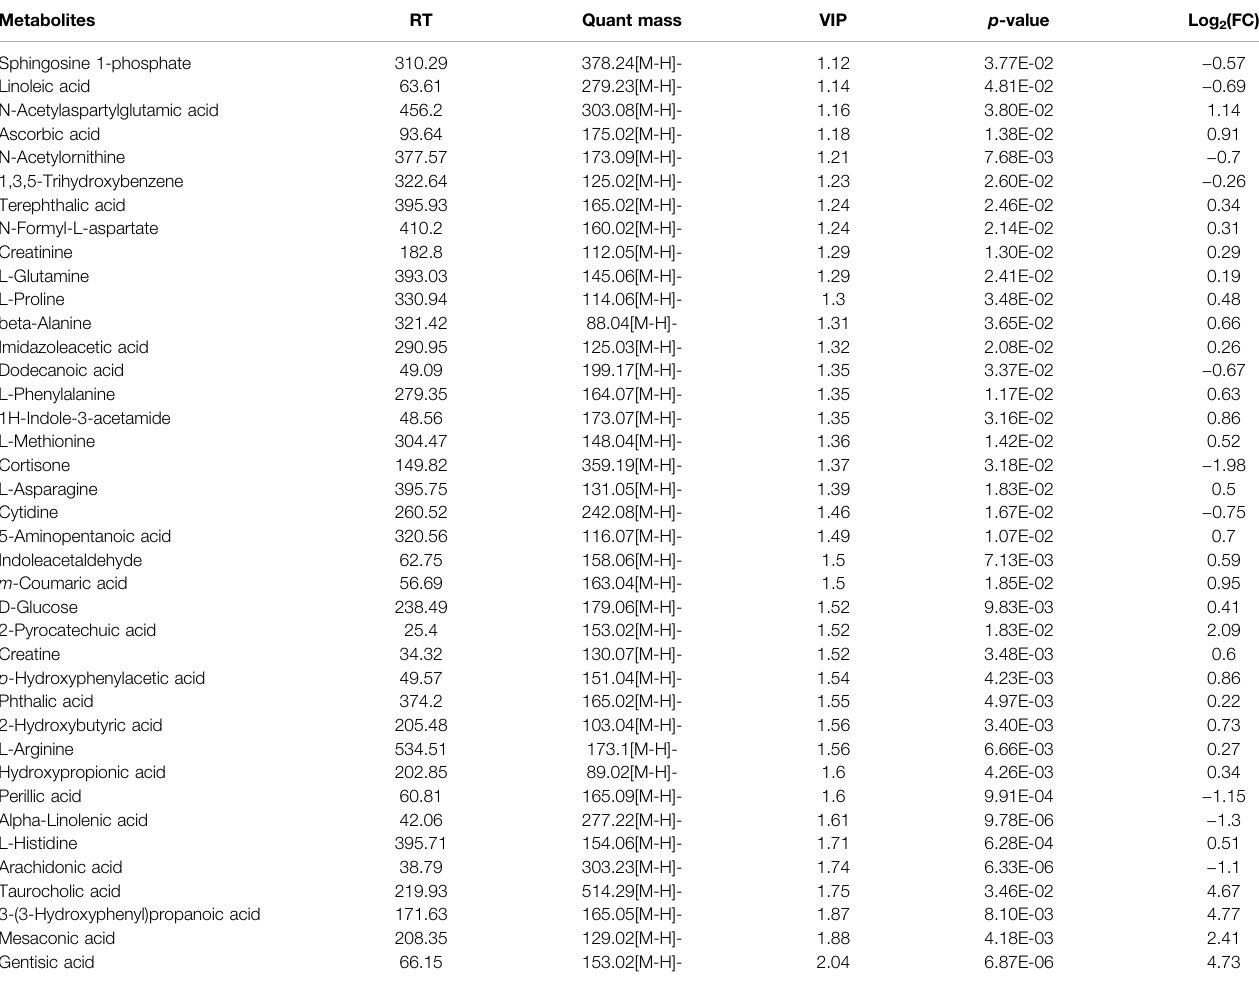
TABLE 1 | The 39 different gut-derived metabolites of MCAO/R male rats were obtained from the negative ion scan modes. Metabolites